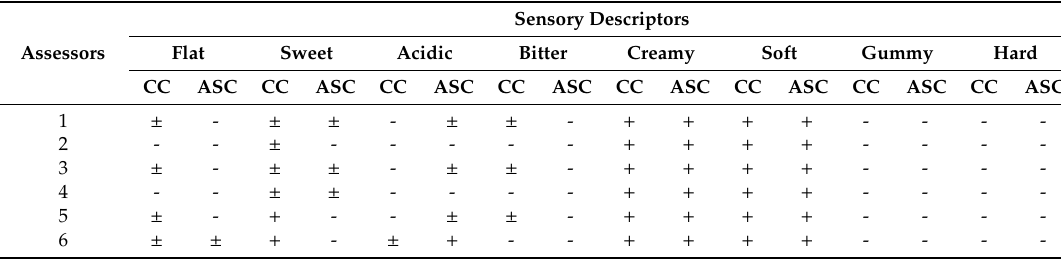
Table 4. Comparison between taste (flat, sweet, acidic, and bitter) and texture (creamy, soft, gummy, and hard) attributes of 48 h refrigerated Giuncata cheese samples with (ASC) and without (control cheese, CC) autochthonous starter culture.